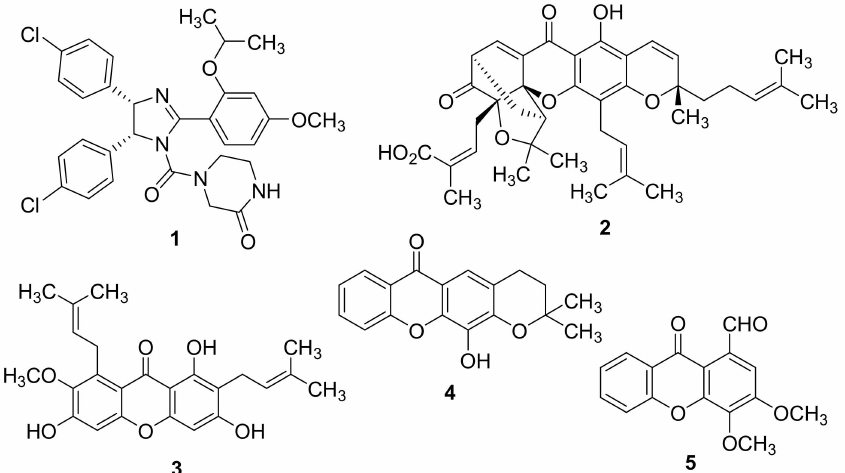
Figure 1. Chemical structures of nutlin-3A ( 1 ), gambogic acid ( 2 ), α -mangostin ( 3 ), 12-hydroxy-2,2- dimethyl-3,4-dihydro-2 H ,6 H -pyrano[3,2- b ]xanthen-6-one ( 4 ), and 3,4-dimethoxy-9-oxo-9 H -xanthene- 1-carbaldehyde ( 5